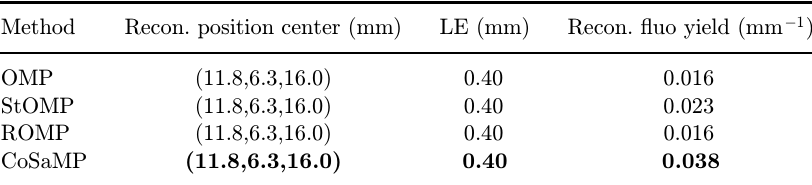
Table 2. Reconstructed results of single °uorescent